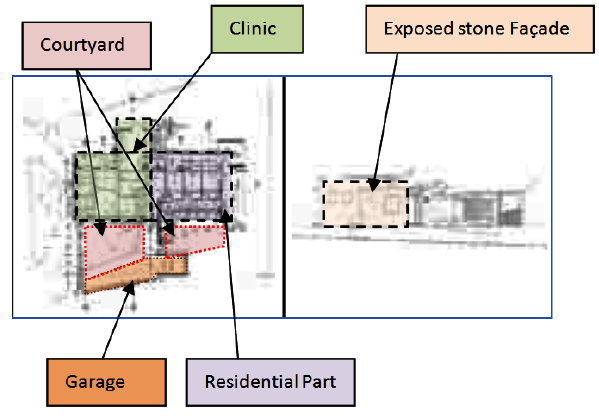
Figure 19. Details on plan and elevation